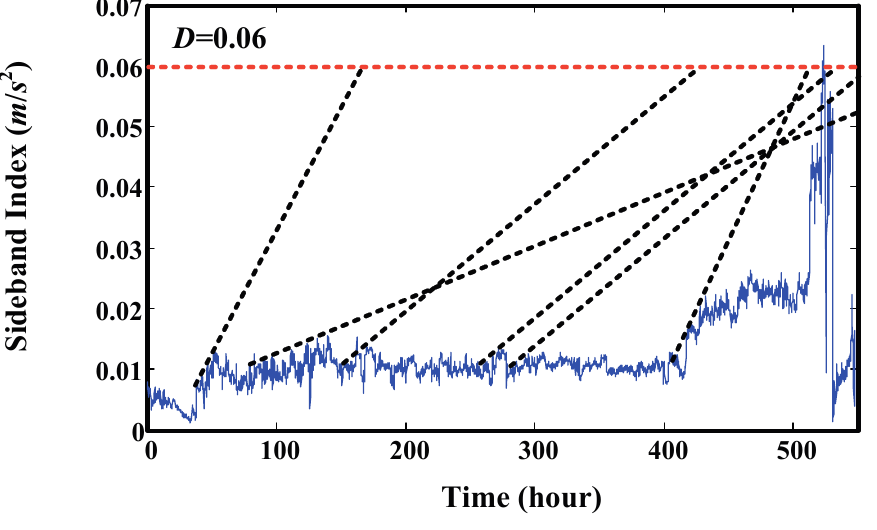
Figure 19. Explaining the great variance of predicted RUL